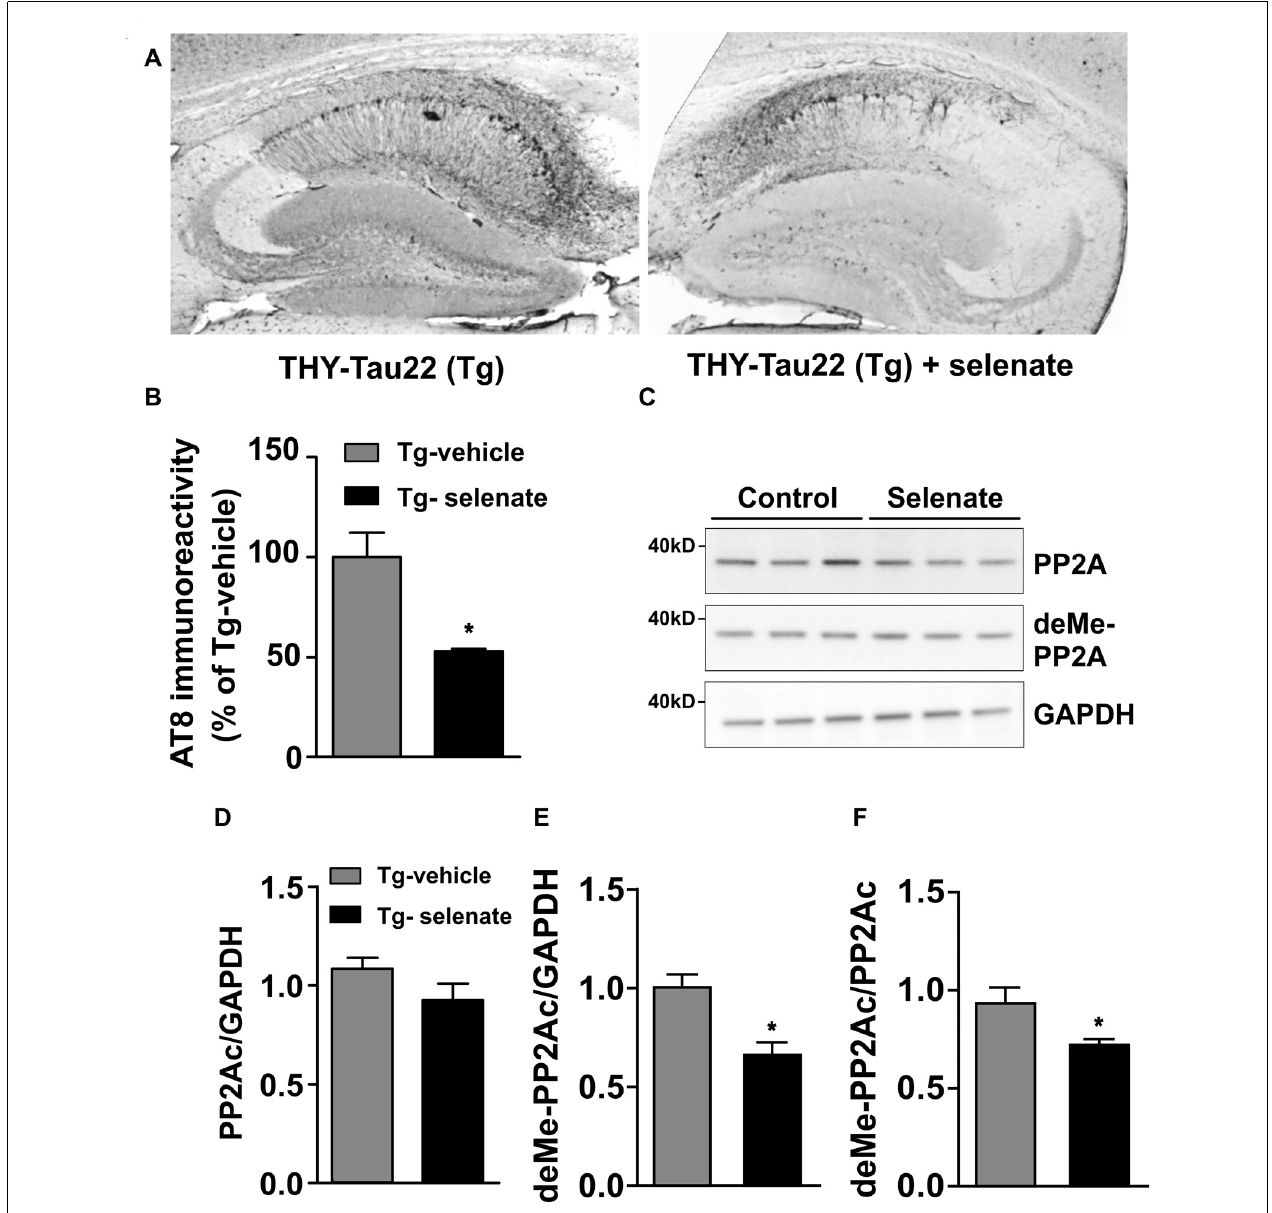
FIGURE 6 | Selenate reduces AT8 immunoreactivity and antagonizes PP2A-demethylation in Tg mice. (A) Representative immunohistochemical sections from a vehicle-treated Tg mouse (left) and an animal that received selenate (right). Note the reduced AT8 immunoreactivity in the mouse treated with selenate. (B) Quantification of immunohistochemical AT8-staining from both groups. Selenate treatment reduced AT8-immunoreactivity to about 50% ( p = 0.0027). (C) Immunoblots of PP2Ac and demethylated PP2Ac in vehicle-treated and selenate-treated Tg. (D,E) Quantification of the levels of PP2Ac and demethylated PP2Ac, respectively. The amount of demethylated PP2Ac is significantly lower after treatment with selenate, supporting higher PP2A activity under treatment. (F) The amount of demethylated PP2Ac (deMe-PP2Ac) normalized to the amount of PP2AC. Mean ± SEM is given. * p < 0.05, n = 3 per